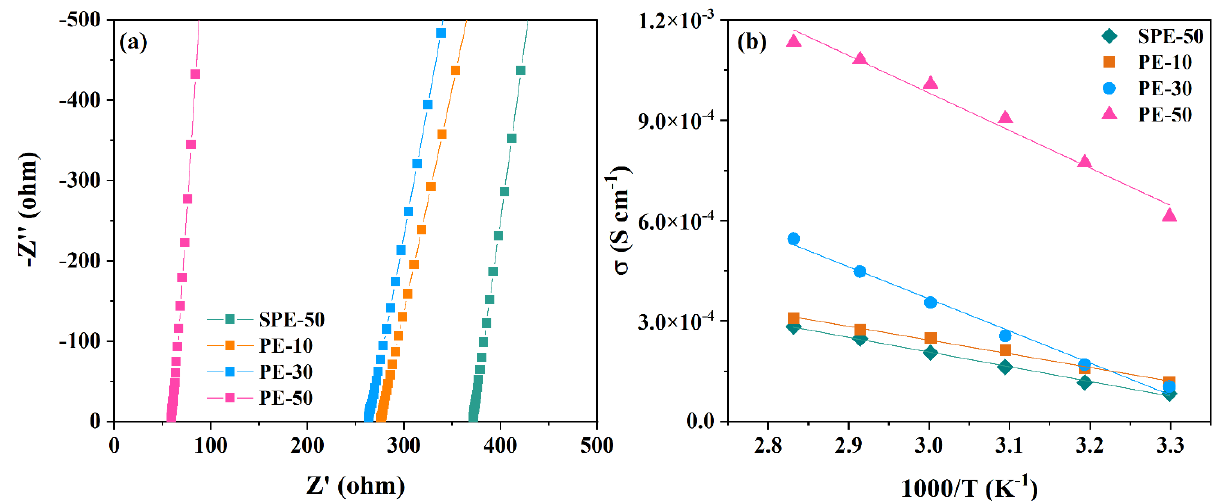
Figure 5. ( a ) Comparison of Nyquist plots of PEs at RT and ( b ) ionic conductivity versus temperature plots of PEs.